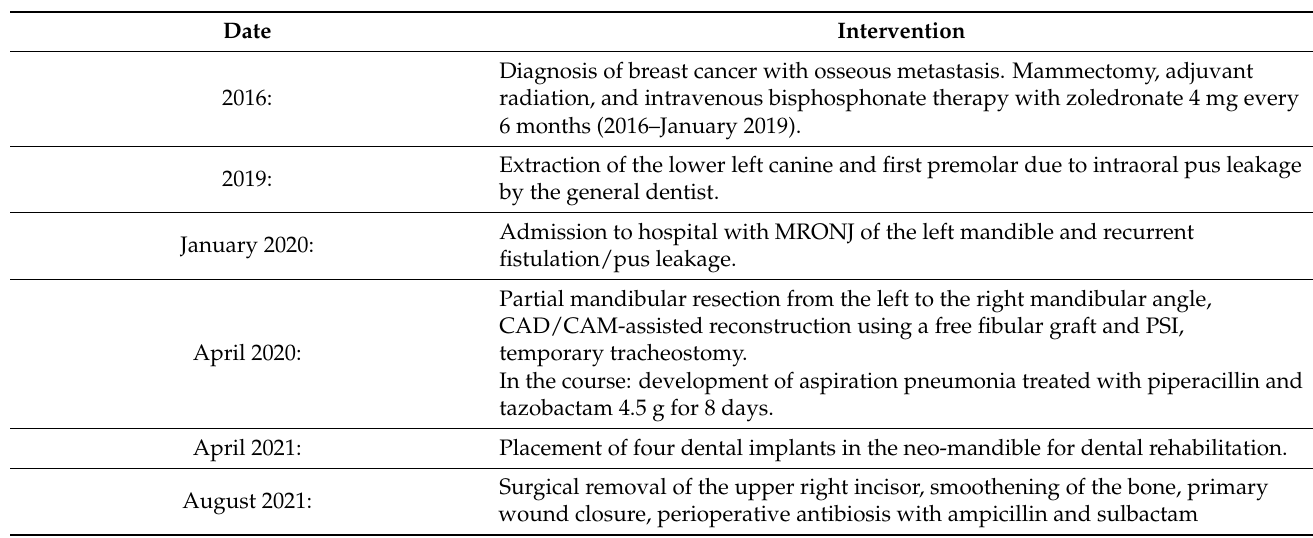
Table 2. Timeline of patient case no. 2, PSI = patient-specific implant, CAD/CAM = Computer-Aided Design and Manufacturing.